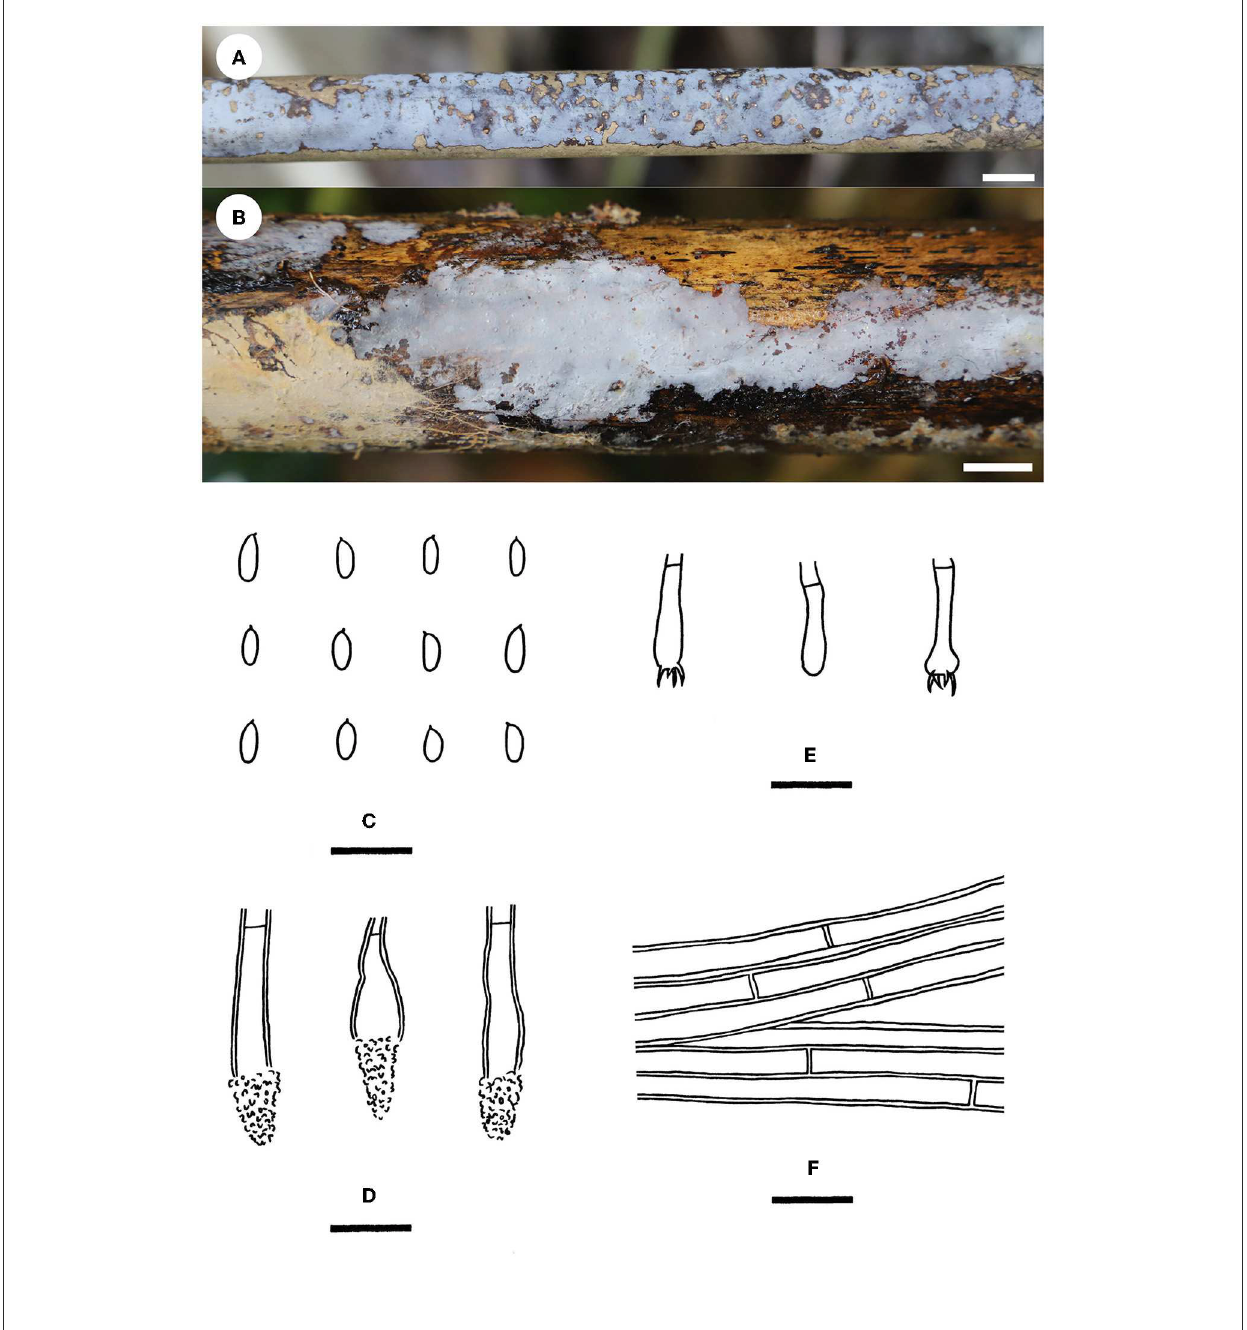
FIGURE7 Phlebiopsis cana [ (A, C–F) from the holotype He 5958; (B) from He 5728; scale bars: (A, B) = 1cm; (C–F) = 10 µ m]. (A, B) Basidiomes; (C) Basidiospores; (D) Basidia and a basidiole; (E) Lamprocystidia; (F) Hyphae from subiculum.